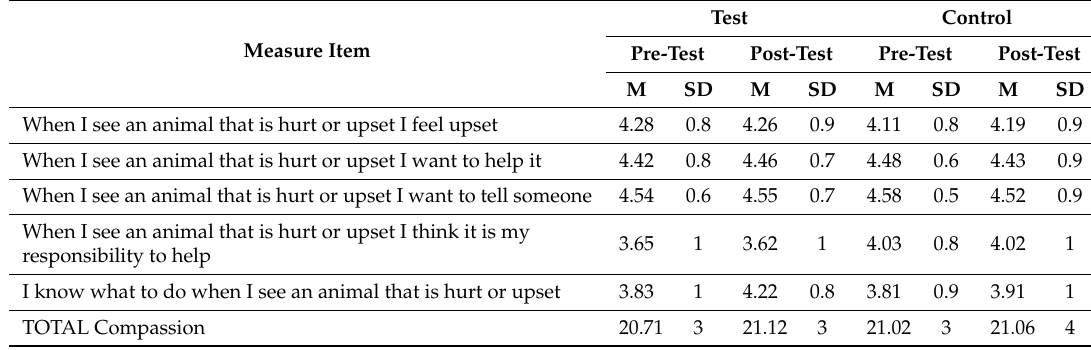
Table 1. Descriptive statistics for children’s compassion towards animals.